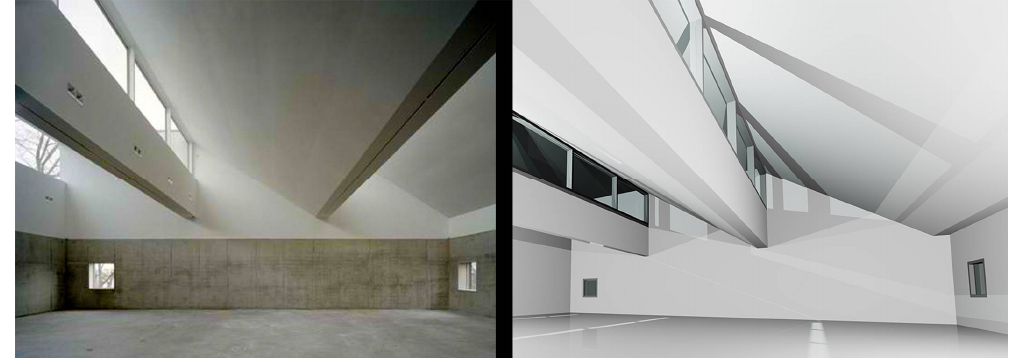
Figure 7. Renderings vs reality. Tham & Videgård Arkitekter, Kalmar Museum of Art—Sweden (student Sonia Sacchini).